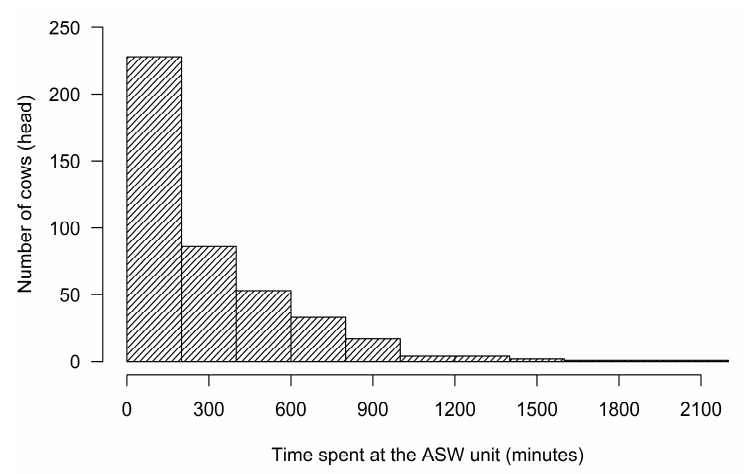
Figure 5. Frequency distribution of cumulative time spent by 430 cows accessing the automatic supplement weighing (ASW) units over 62 days of data collection.